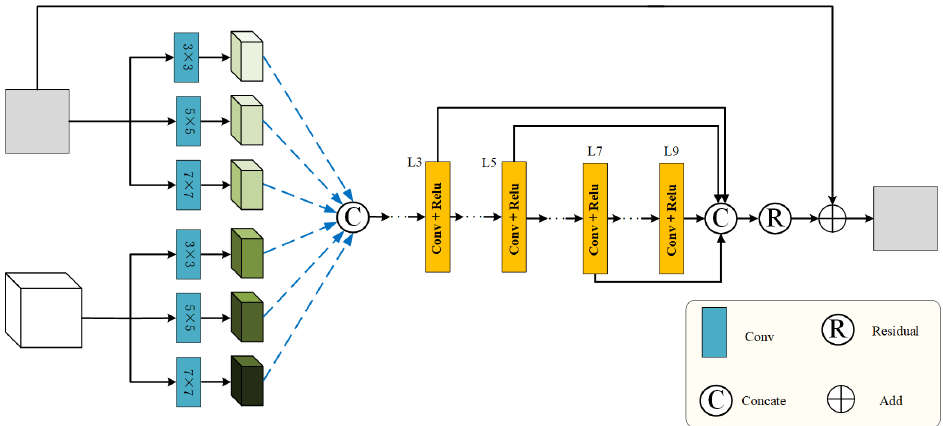
Figure 12. Structure of HSID-CNN [28].